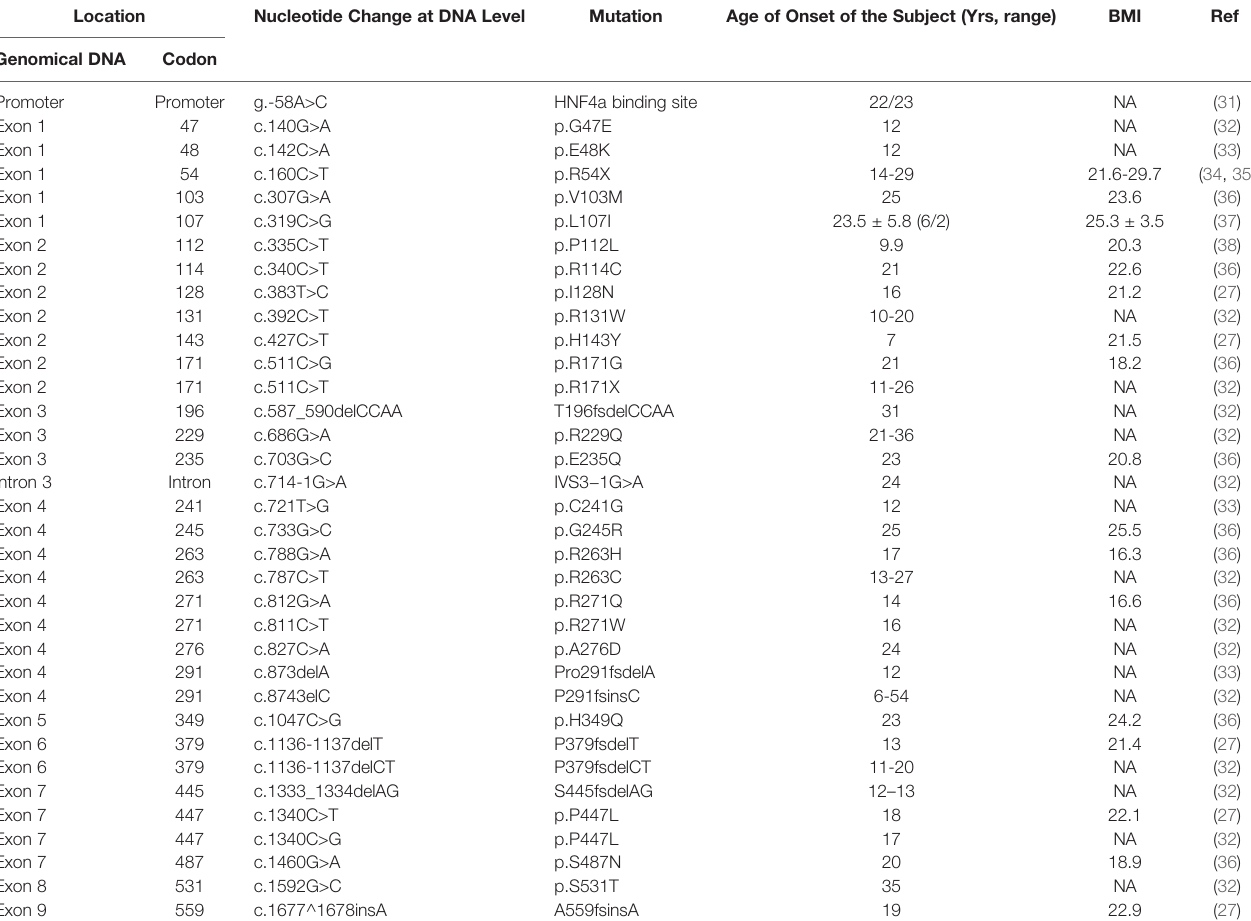
TABLE 1 | Comparison of the onset ages of diabetes caused by different MODY3 associated SNPs.